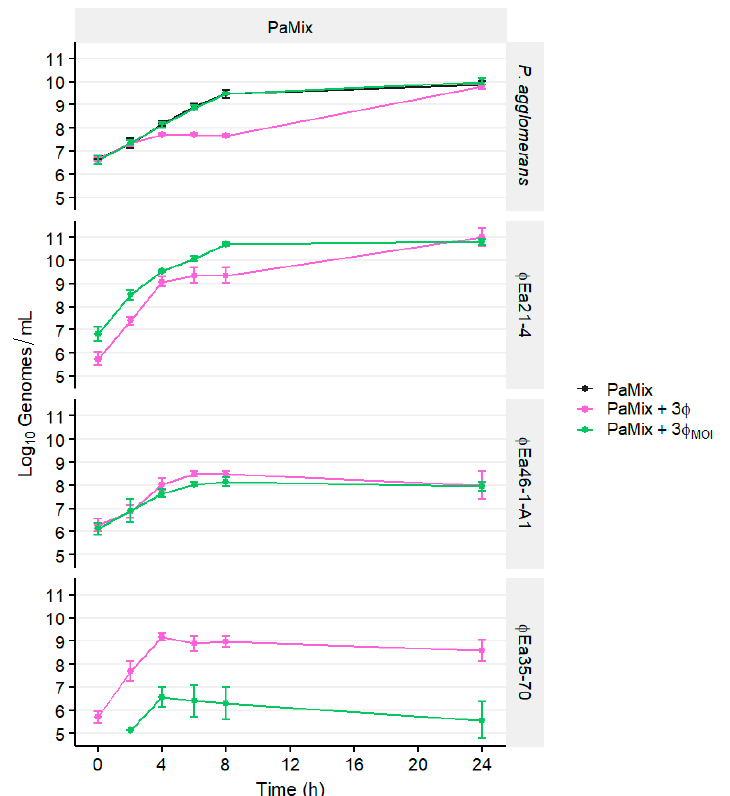
Figure 5. Effect of MOI on the growth of PaMix over 24 h. PaMix was grown with no phage, or infected with the three phages ϕ Ea21-4, ϕ Ea46-1-A1, and ϕ Ea35-70, each at an MOI of 1 (3 ϕ ) or at 10, 1, and 0.01, respectively (3 ϕ MOI ). The banners on the right indicate the host or phage quantified. Genomic titers of P. agglomerans and each phage were determined with qPCR. Data are the mean ± SD of three replicates. The missing data point for ϕ Ea35-70 at 0 h ( ● ) was below the limit of detection.